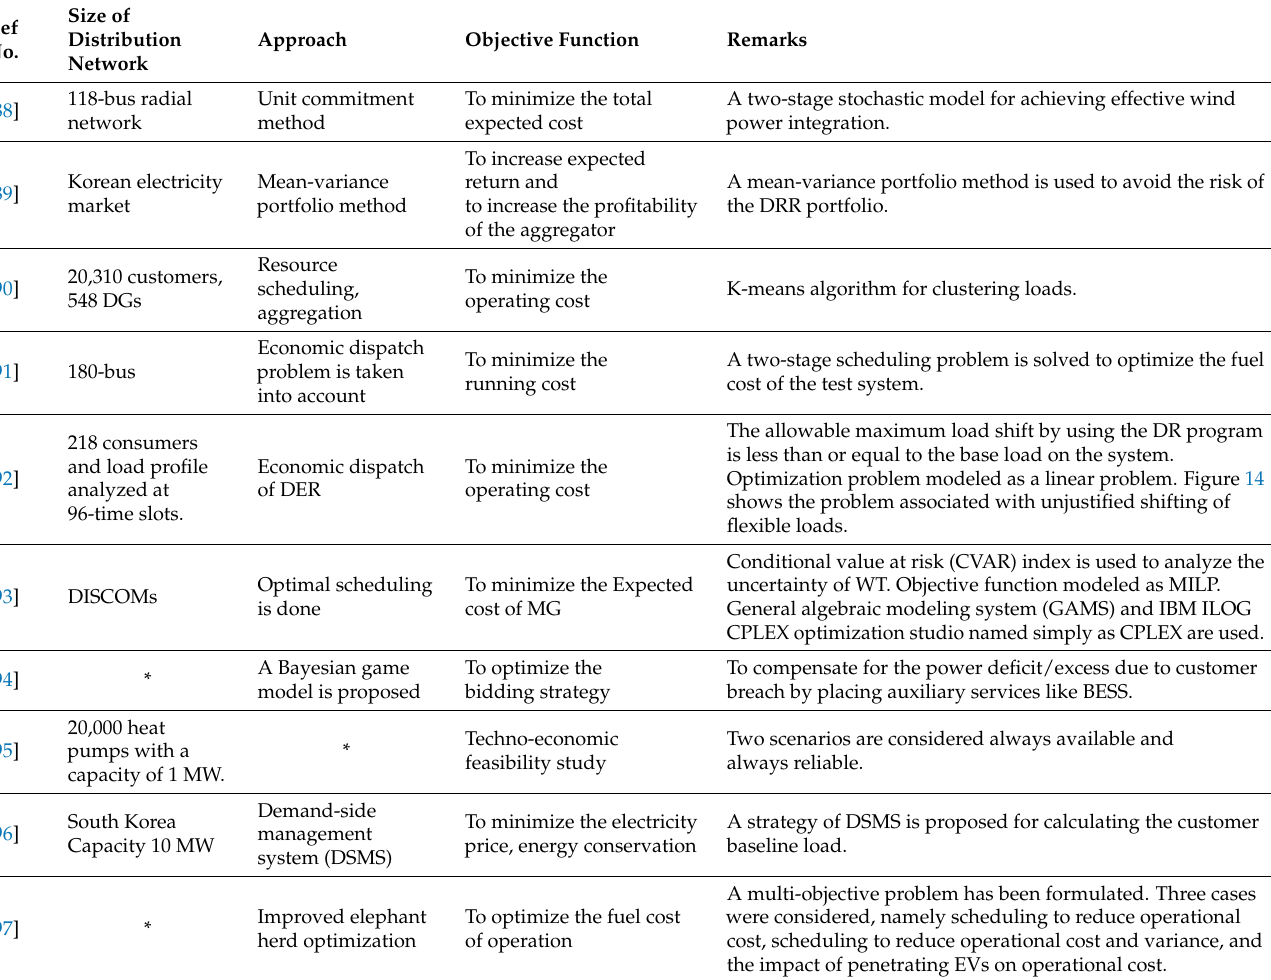
Table 6. A literature survey on various